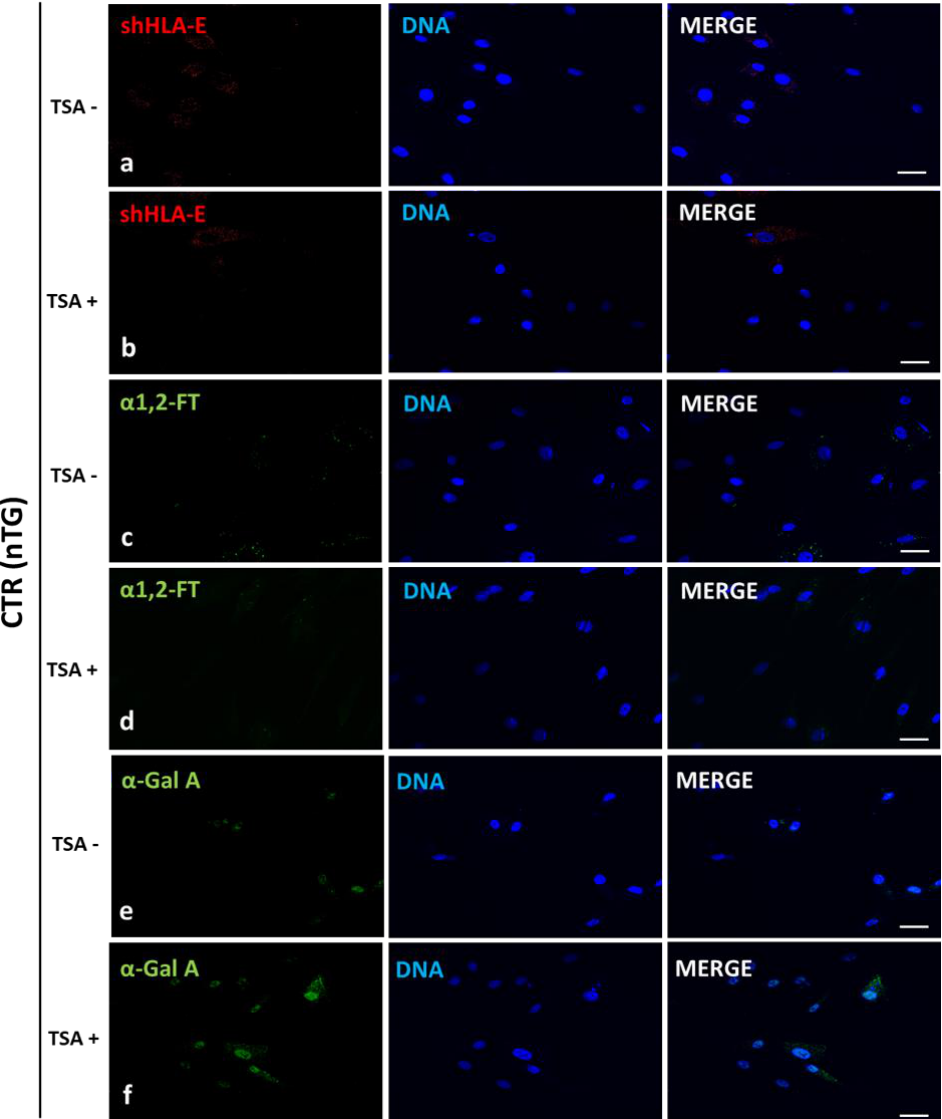
Figure 4. Immunofluorescence analysis of the ex vivo-expanded porcine ACFCs epigenomically modulated (TSA+) ( b , d , f ) and not modulated with trichostatin A (TSA − ) ( a , c , e ). Representative microphotographs of immunofluorescence localization of swine homolog of human leukocyte antigen-E (shHLA-E; ( a , b )) , α1,2 - fucosyltransferase (α1,2 -FT; ( c , d )) and α - galactosidase A (α -Gal A; ( e , f )) in ACFCs stemming from non-transgenic pigs (CTR nTG). Immunofluorescent staining with Alexa Fluor 488- or Cy3-labelled secondary antibodies (green and red fluorescence, respectively) and DAPI counterstaining (blue fluorescence). Scale bars represent 100 μm. Immunoreaction was performed on ex vivo proliferating porcine ACFCs derived from at least three pigs of each experimental group. TSA + ACFCs displayed more highly intensified signals identified for not only shHLA- E but also α1,2 - FT and α -Gal A proteins in control non-transgenic (CTR nTG) ACFCs ( b , d , f ). No positive signals originating from either shHLA- E representative of MHC or α1,2 - FT and α -Gal A enzymes were observed in the TSA − CTR nTG group ( a , c , e ).